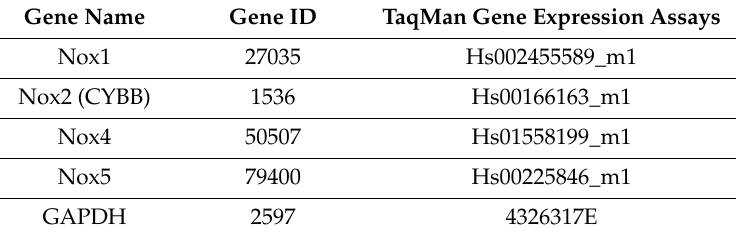
Table 1. Human Taqman primer sequences used to amplify NADPH oxidase (Nox) isoforms for human Tenon’s fibroblasts